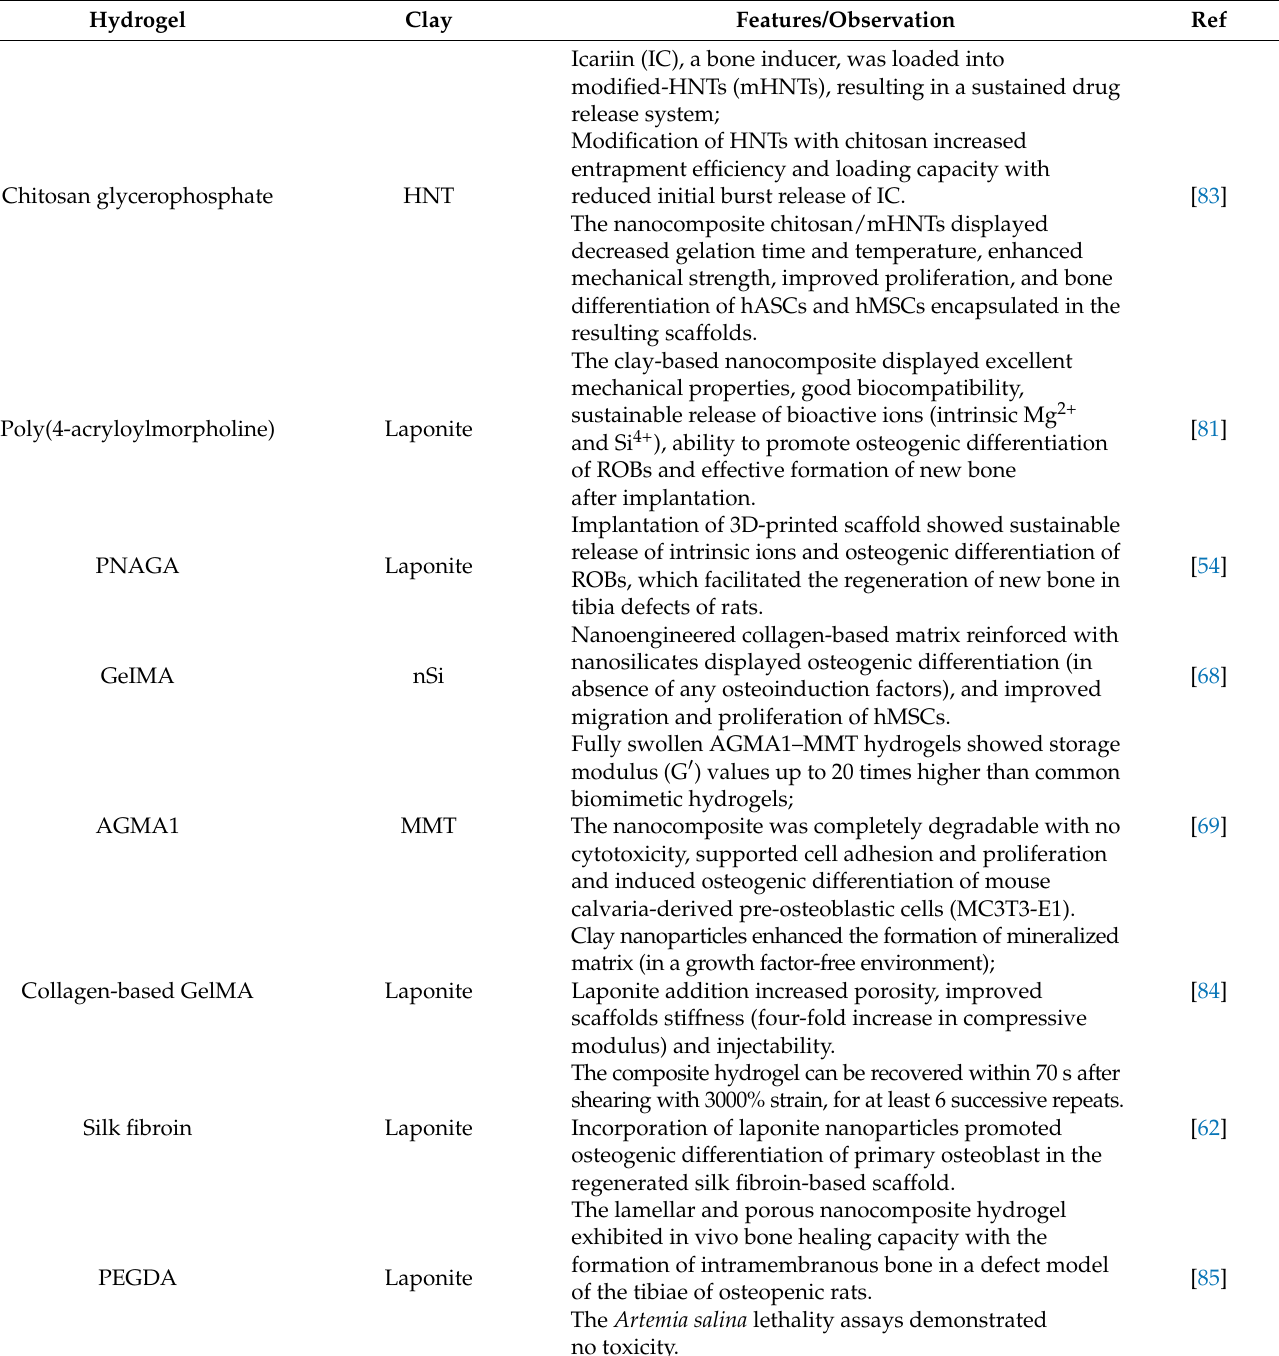
Table 2. Clay nanoparticles in hydrogel nanocomposites for bone tissue regeneration. Hydrogel